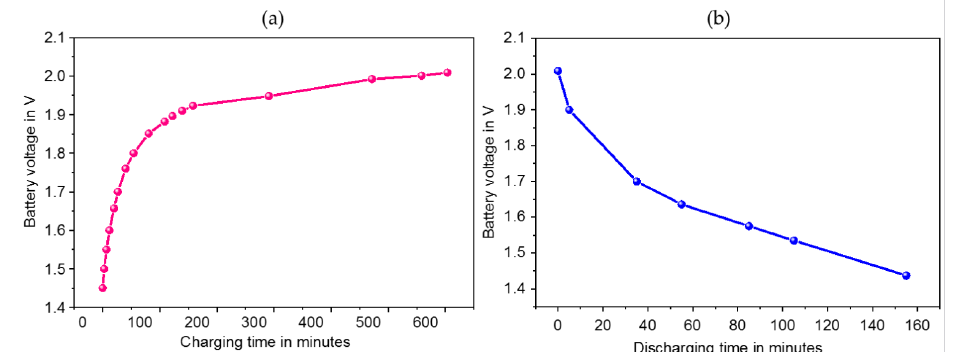
Figure 16. ( a ) Charging time of the Lithium coin cell battery versus stored voltage ( b ) Discharging time versus the stored battery